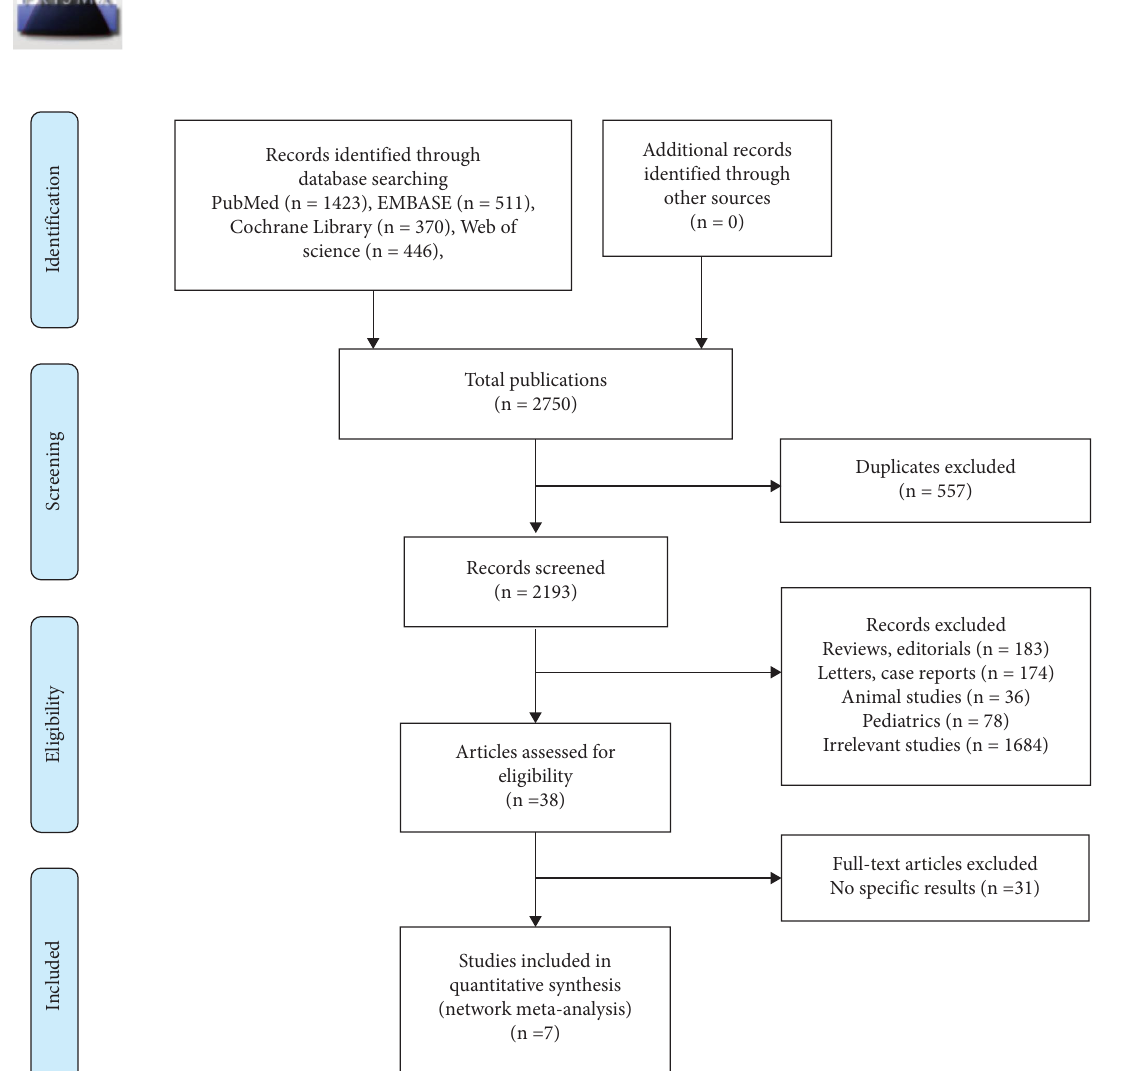
Figure 1: Te fowchart of studies evaluating nutritional supports for TBI through the selection